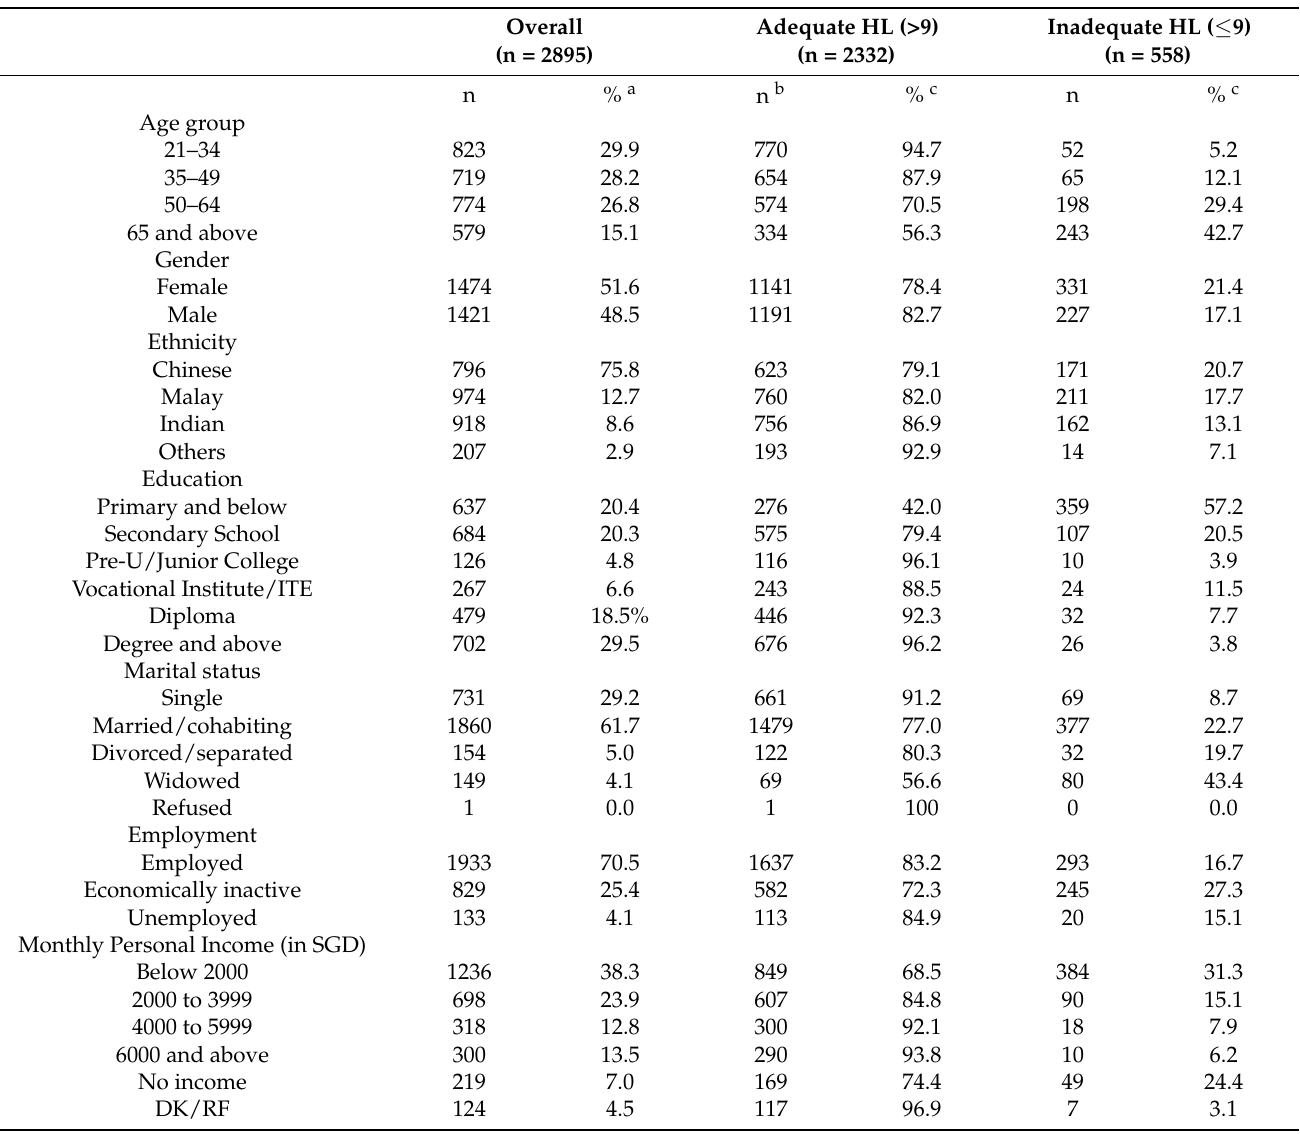
Table 1. Sociodemographic characteristics of the